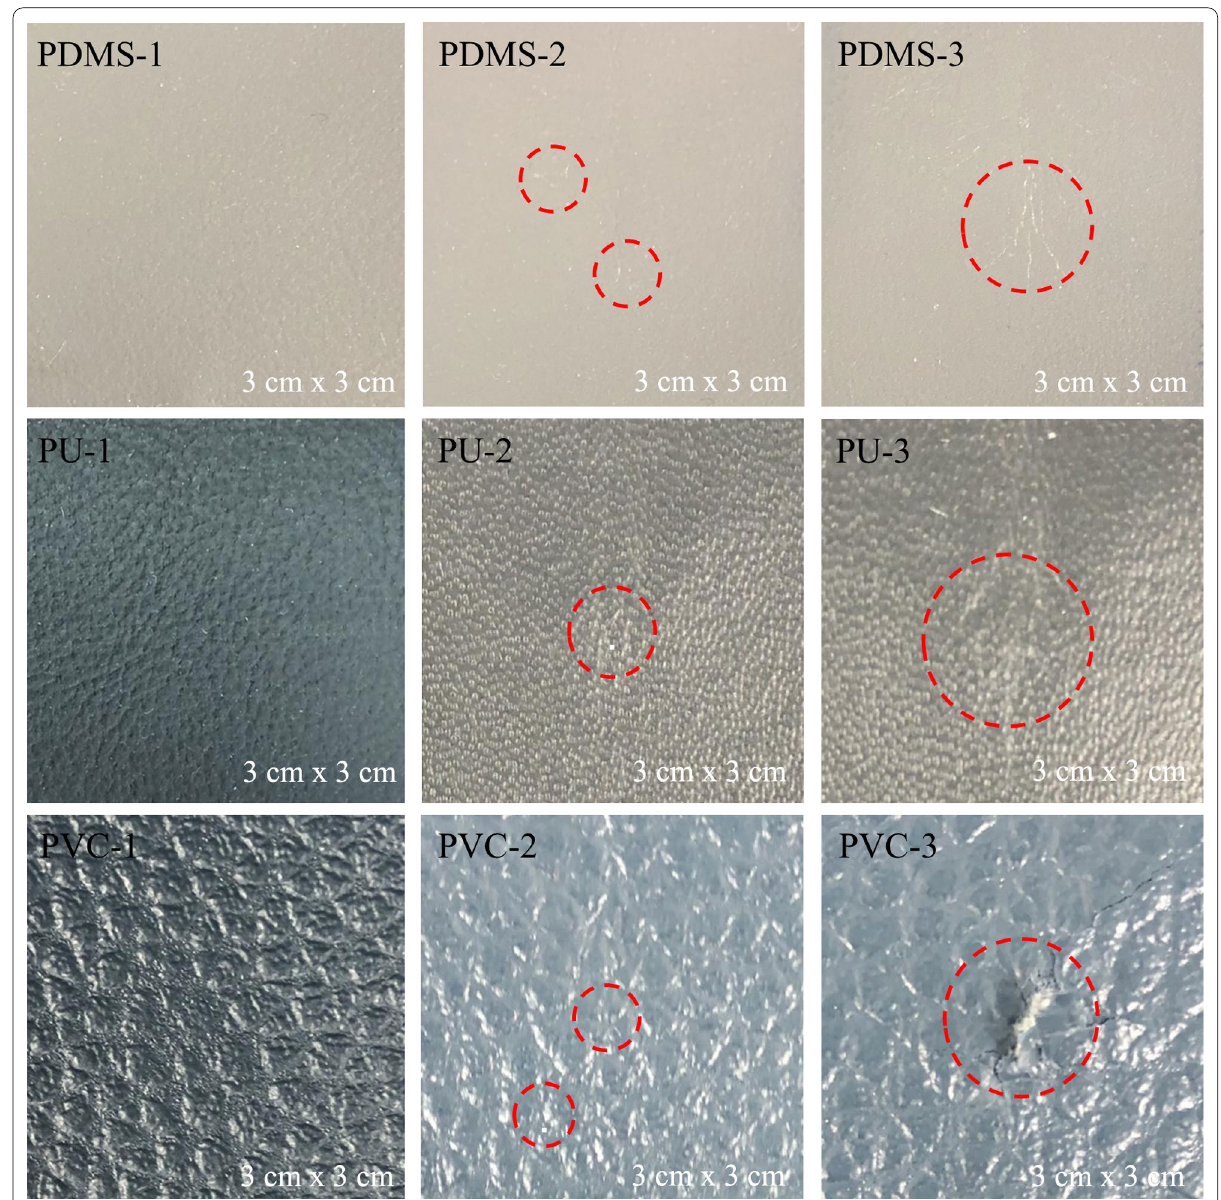
Fig. 5 Test results of flexural resistance of different leather coatings. x-1 original sample; x-2 ambient temperature test; x-3 low temperature test (x: PDMS, PU,